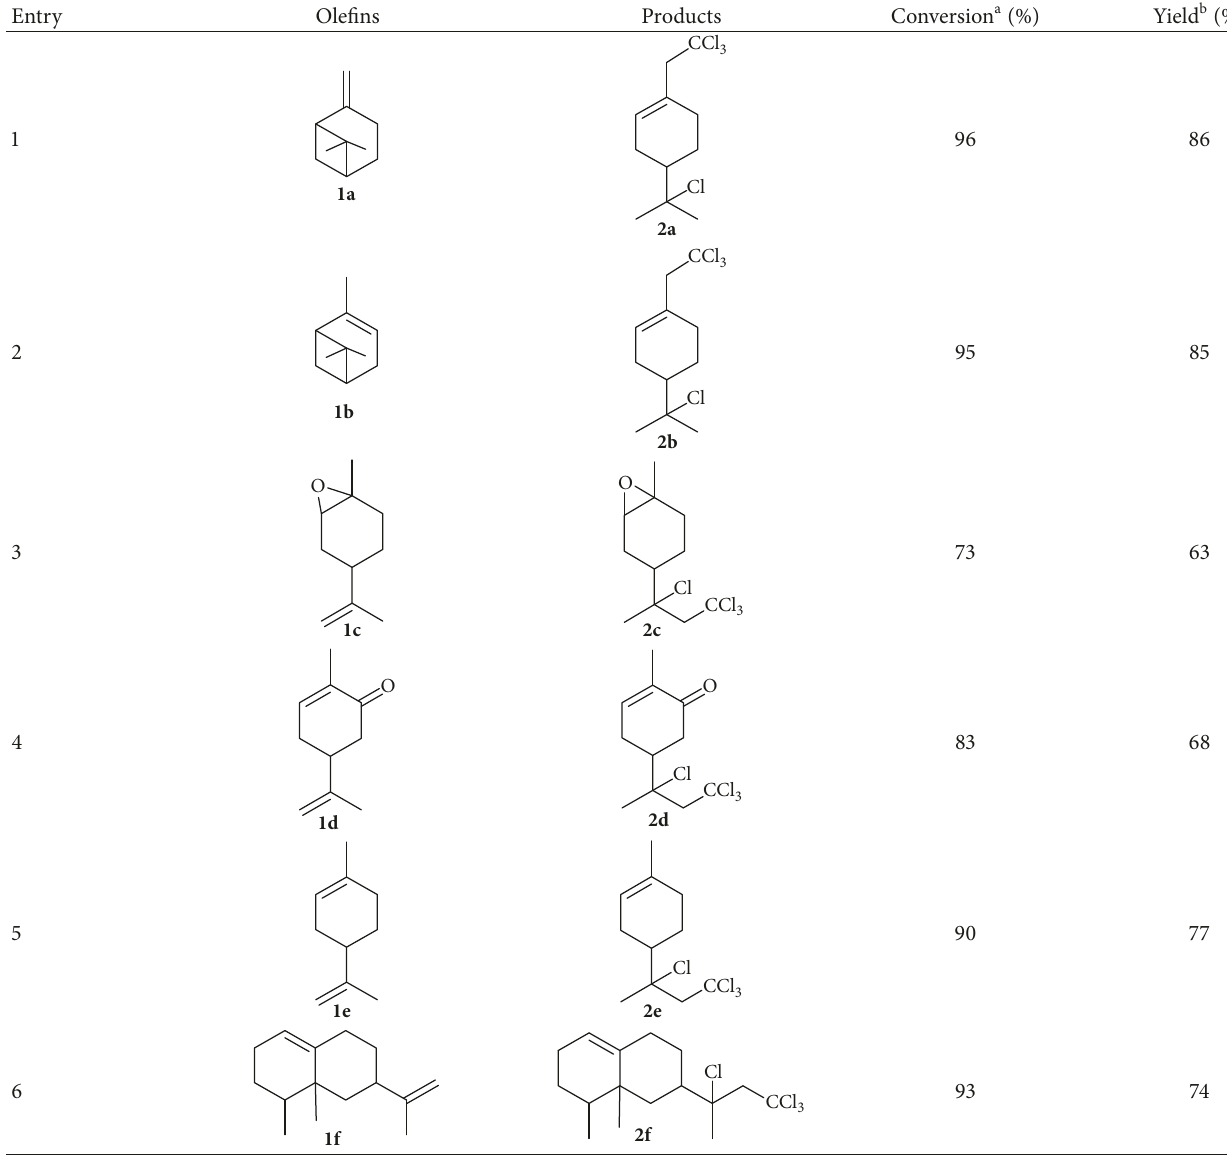
Table 1: Synthesis of polyorganochloride 2a – f